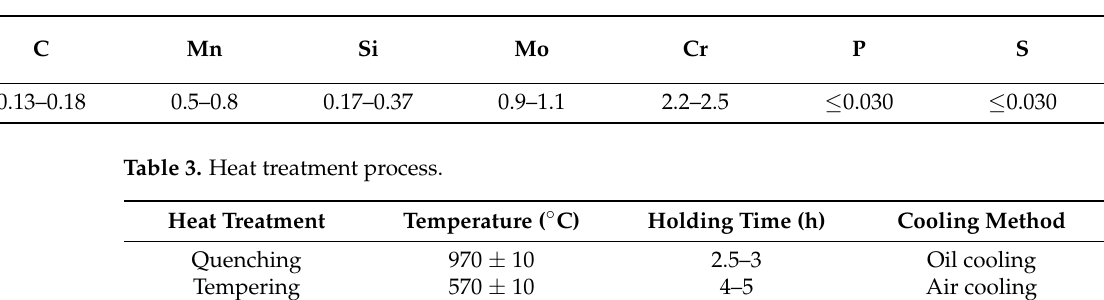
Table 2. Chemical composition of KMN-I (wt.%).